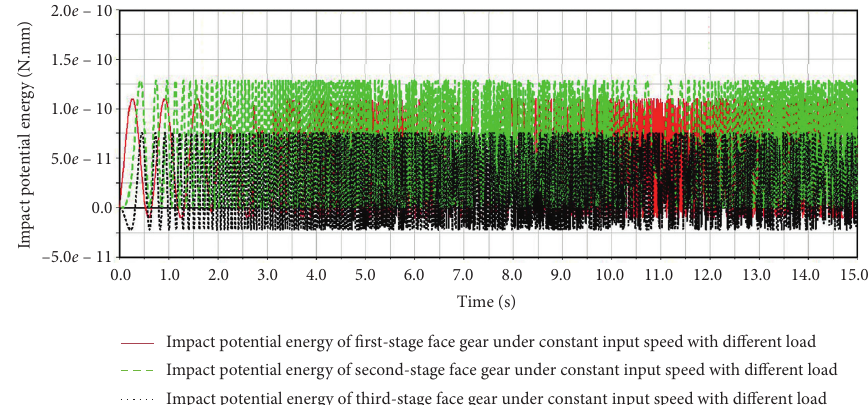
Figure 24: Impact potential energy of multistage face gears pair under constant speed and variable